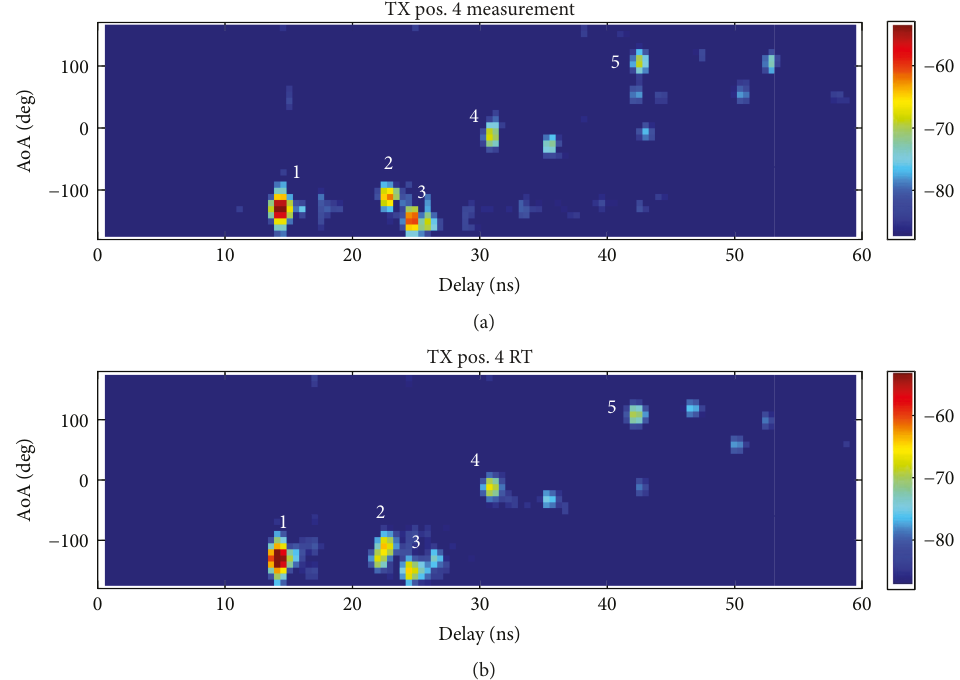
Figure 9: Measured (a) and RT-simulated (b) power-angle-delay pro fi le for Tx position 4 in the basement scenario. Note that all identi fi ed multipath components are present within the 60 ns delay range in the LOS region.